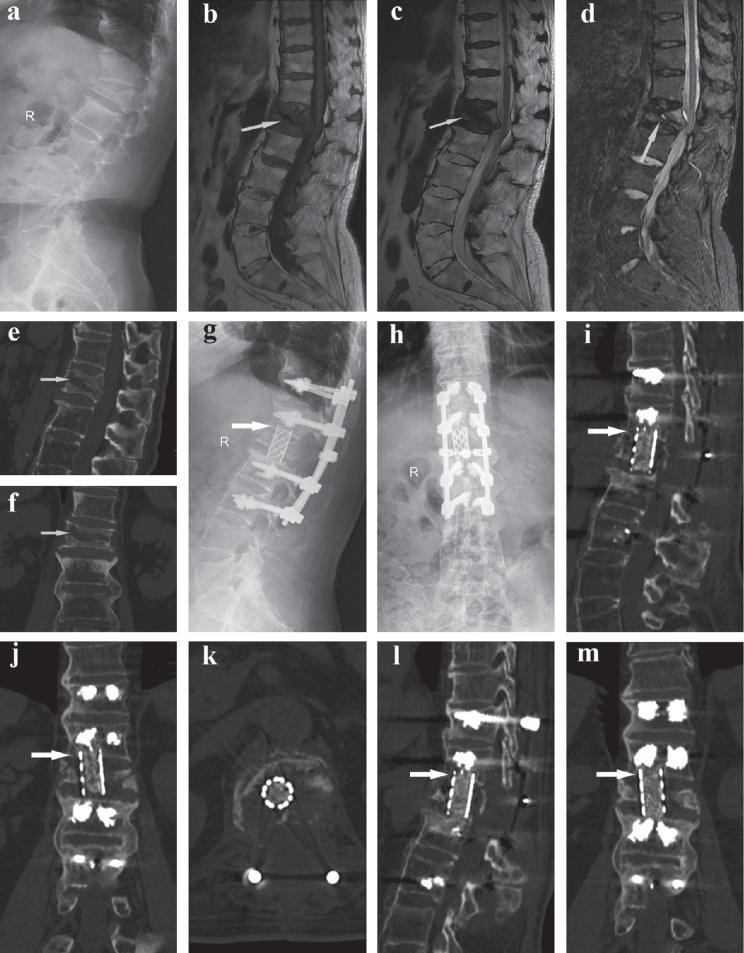
A 67-year-old male patient experienced OVCFs with IVC complicated by neurological deficits and underwent PVCR treatment. (a) Preoperative sagittal plain radiographs revealed collapsed fracture at L1 and kyphosis. (b, d) Sagittal T1- and T2-weighted MRI and STIR MRI scans showed a decreased signal in the intravertebral cleft in L1. (e, f) Coronal and sagittal CT showed an IVC in L1. (g, h) Immediate postoperative plain radiographs showed corpectomy, screw fusion, increased anterior vertebral height, and restored kyphosis. (i–m) Coronal and sagittal CT showed no reduction in vertebral height and no kyphosis recurrence at the 1- and 2-year follow-up examinations.